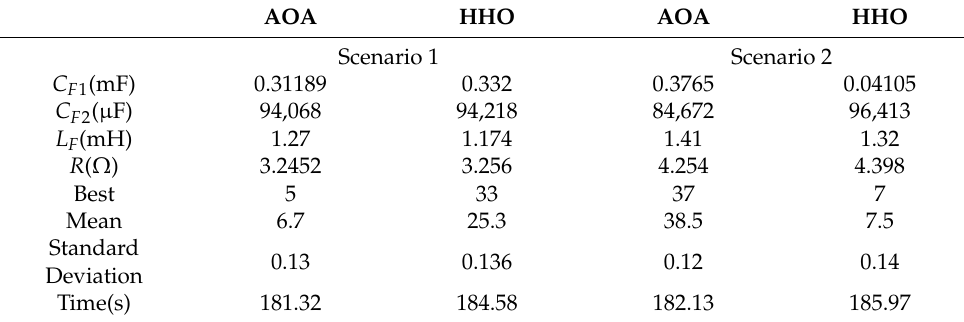
Table 4. The optimal filter parameters and the best fitness values.